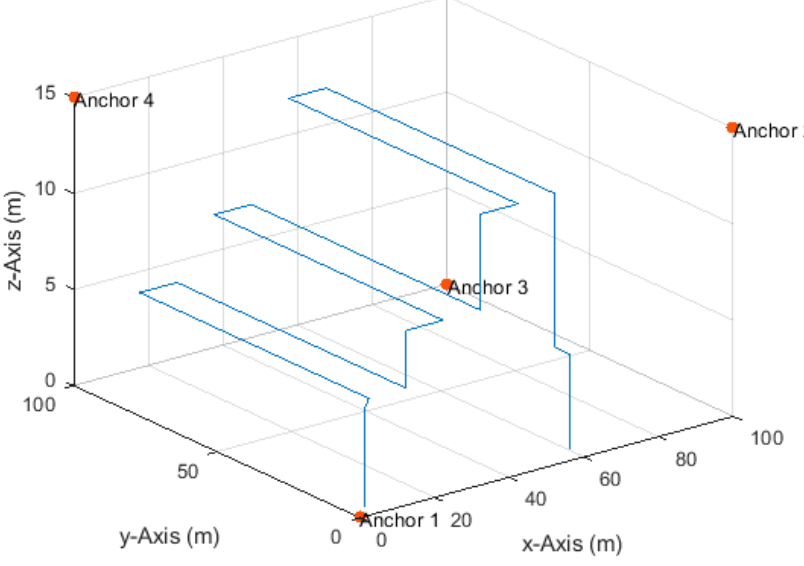
Figure 18. Anchor node arrangement and the linear paths.